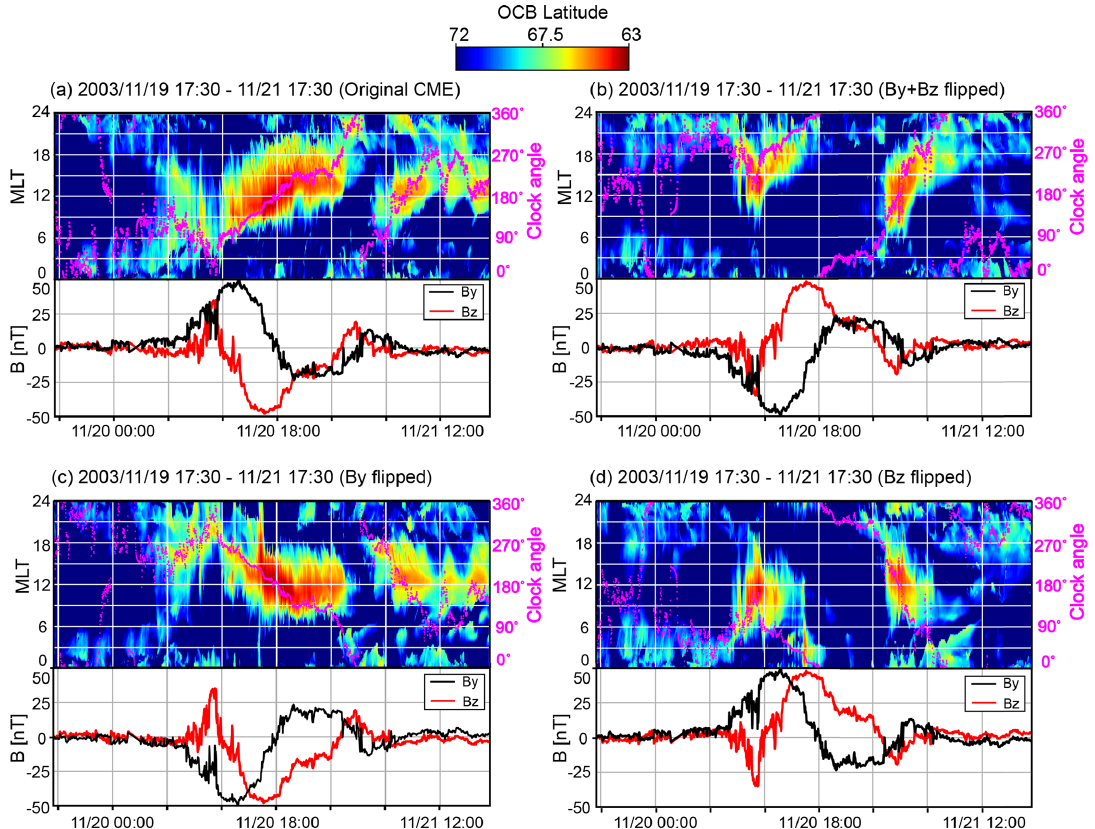
Figure 8. Modeled OCB dynamics during the 20 November 2003 geomagnetic storm. Color-coded color maps indicate the OCB latitude. Superimposed plots in magenta indicate the IMF clock angle. Bottom plots in each panel show the B y (in black) and B z (in red) components in GSE coordinates. Panel (a) shows the original CME. Panel (b) is the run with both B y and B z flipped. Panels (c) and (d) display cases where B y and B z were flipped correspondingly.